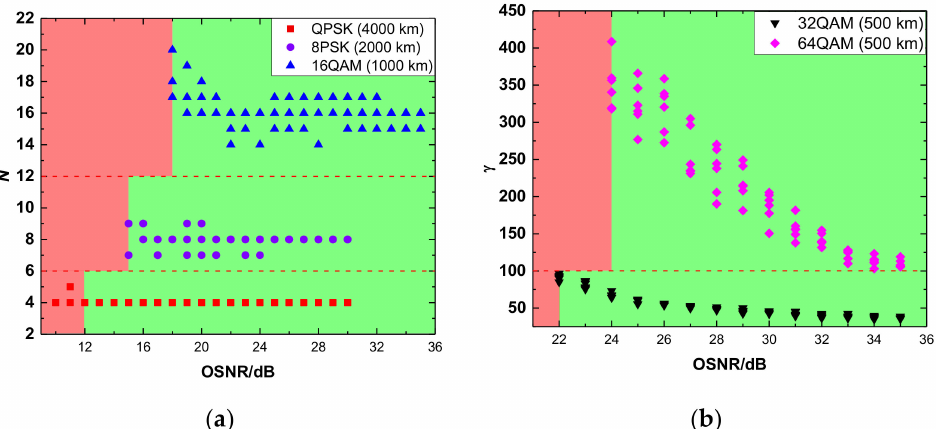
Figure 7. MFI results using the DBSCAN-based algorithm. ( a ) cluster number N of QPSK, 8PSK and 16QAM varies with di ff erent OSNR; ( b ) γ value of 32QAM and 64QAM varies with di ff erent OSNR.